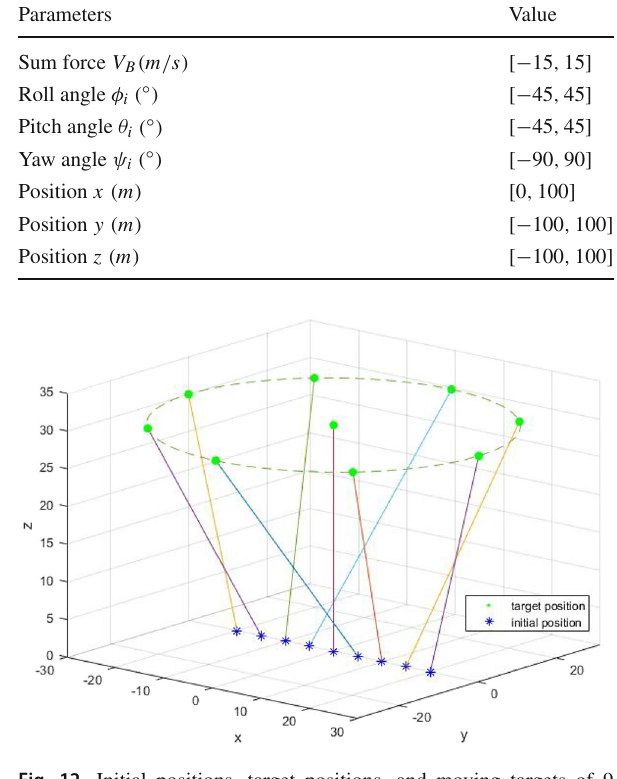
Fig. 12 Initial positions, target positions, and moving targets of 9 UAVs’ group in 3D space position of UAV formation. The green circle indicates the target position of the reconstructed formation, and the col- ored solid line indicates the matching relationship